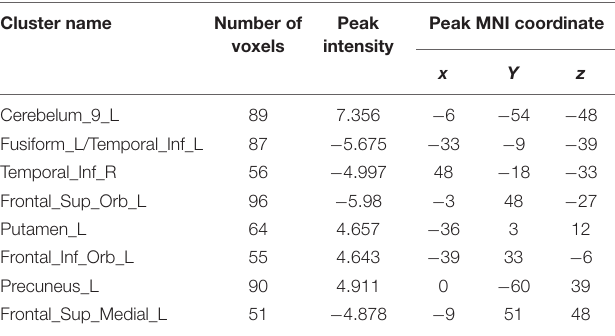
TABLE 5 | MNI coordinates of brain regions showing significant changes in ALFF/ReHo values after chronic hypoxia exposure at high